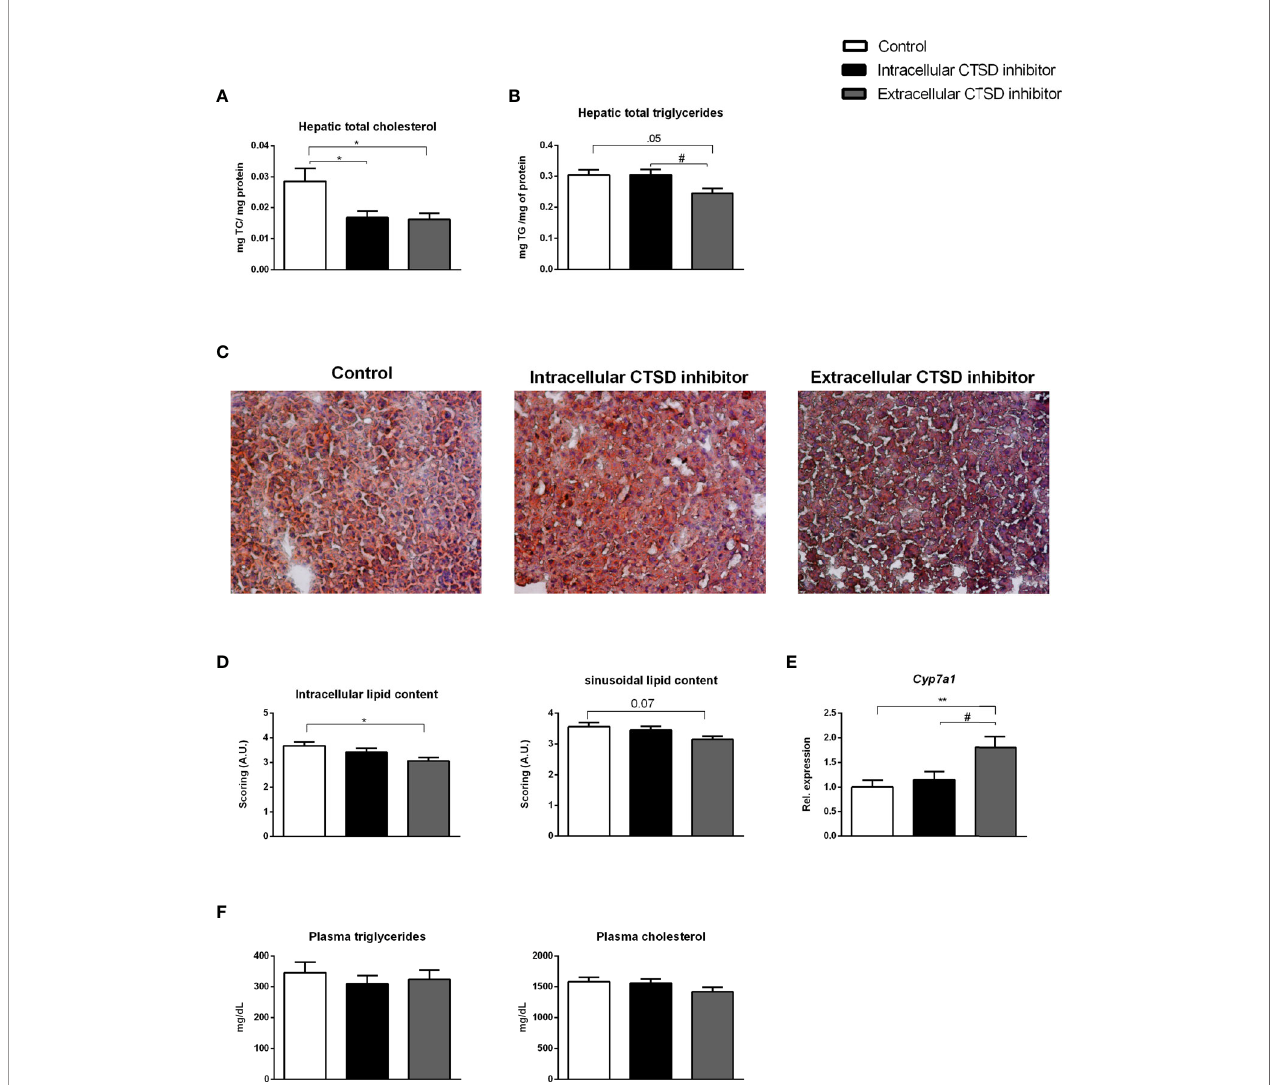
FIGURE 2 | Hepatic and plasma lipids in hyperlipidaemic Ldlr-/- mice with or without CTSD inhibition: (A, B) Total hepatic cholesterol and triglyceride levels. (C) Representative pictures of oil red o staining on frozen liver sections (original magni fi cation, 200x). (D) Scoring of hepatic lipid content of oil red o staining using arbitrary units (A.U.) (E) Hepatic gene expression analysis of Cyp7a1. (F) Plasma triglyceride and cholesterol measurements. Error bars represent ± SEM; n = 16-20 per each group; * represents p<0.05 and ** represents p < 0.01 compared to control mice. # represents p < 0.05 compared to intracellular CTSD inhibitor- treated mice by means of one-way